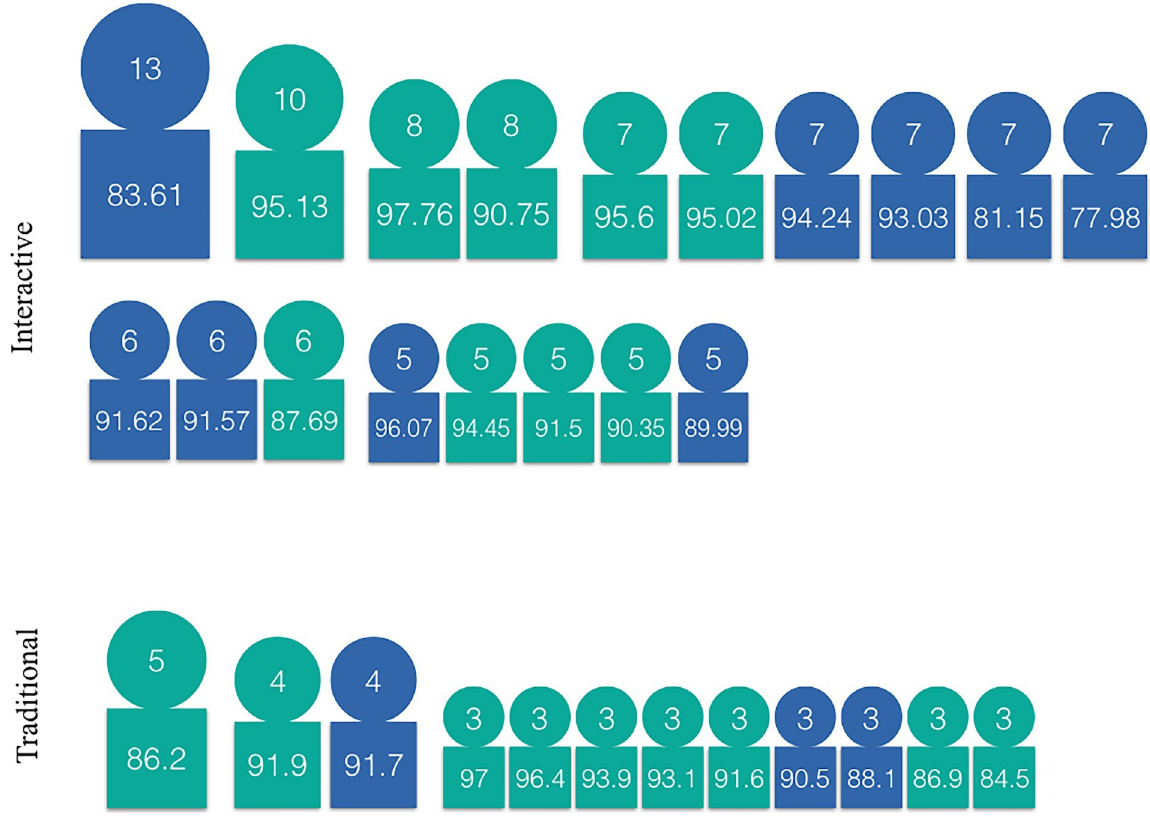
Fig 3. Students receiving the most nominations in the two offerings, by number of received nominations and course grades. Green students are male and blue are female. Recall the ratio of the number of male to female students was 1.8 for the traditional offering and 0.9 for the interactive